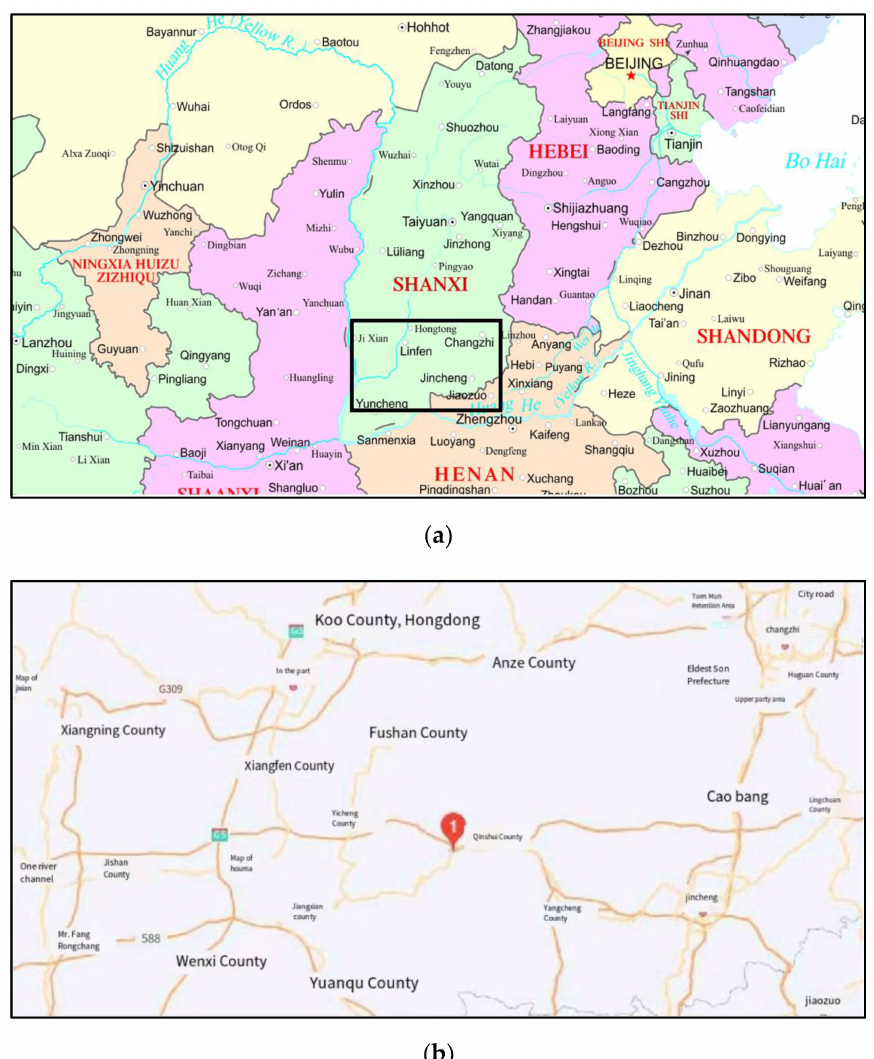
Figure 1. Geographical location diagram of the Sandou Xindu coal industry: ( a ) partial map of China; ( b ) locally enlarged map.